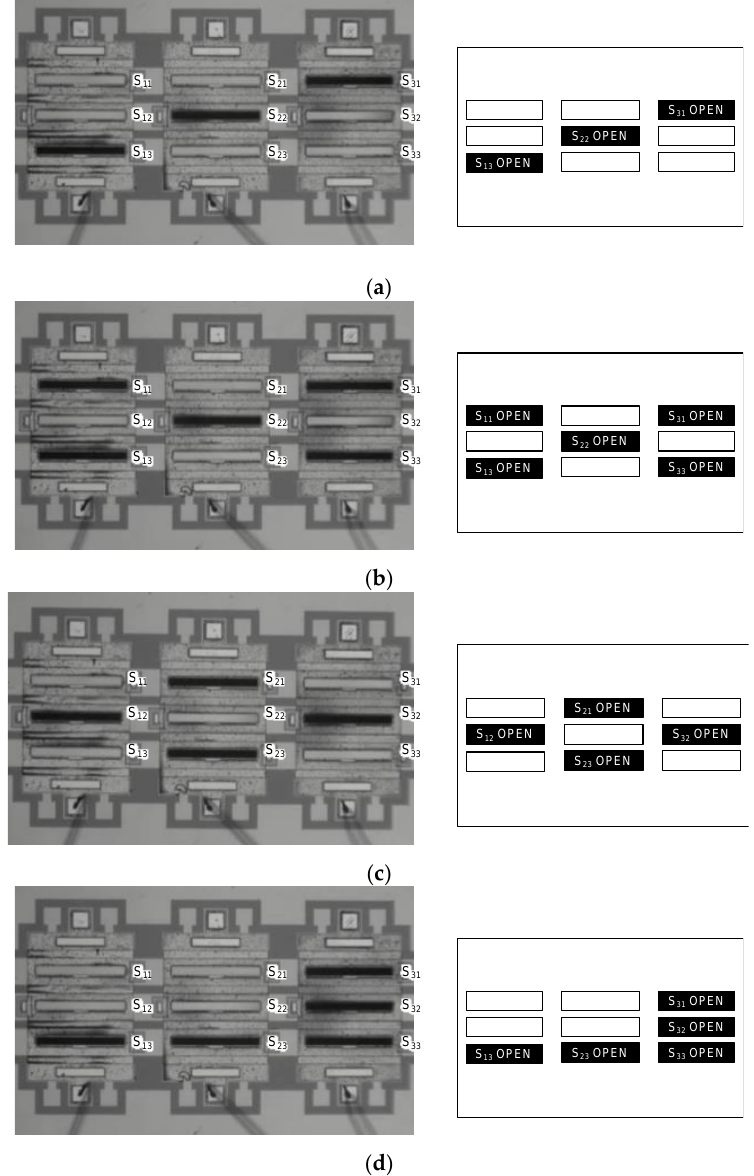
Figure 11. Examples of 3 × 3 shutter array operation. ( a ) Diagonal three elements ( S 13 , S 22 and S 31 ) are addressed. Shutters are also addressed in ( b ) a cross shape ( S 11 , S 13 , S 31 , S 33 and S 22 ), ( c ) a diamond ( S 12 , S 23 , S 32 and S 21 ), and ( d ) a mirror-flipped L-shape ( S 13 , S 23 , S 33 , S 32 and S 31 ).